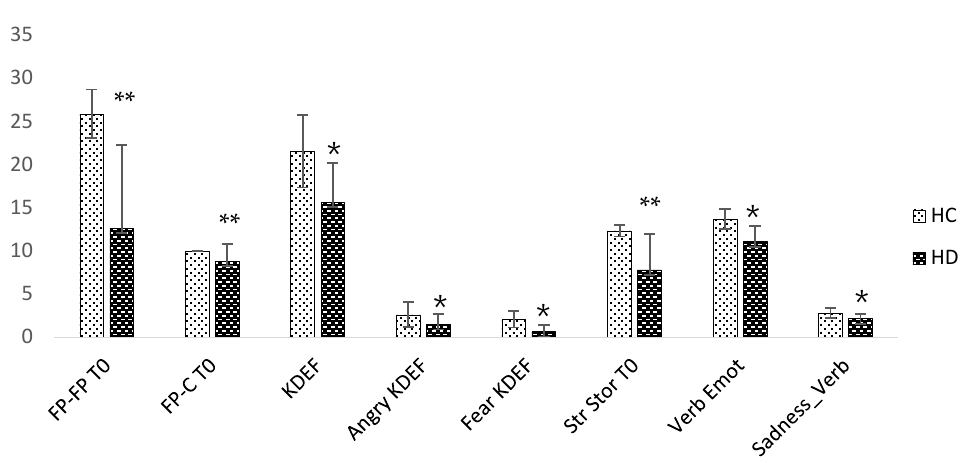
Figure 2. Differences in social cognition at the baseline. HC: Healthy Controls. HD: Huntington’s Disease. FP_FP: Faux-Pas_Faux Pas; FP_C: Faux-Pas_Control; KDEF: Karolinska Directed Emotional Faces; Angry_KDEF: Angry expression at Karolinska Directed. Emotional Faces; Fear_KDEF: Fear expression at Karolinska Directed Emotional Faces; Str_Stor: Strange Stories test; Verbal_Emotions: Verbal Emotions test; Sadness_Verb: Sadness at Verbal Emotions test. * p < 0.05, ** p < 0.01. Error Bar ± 1 standard deviation.